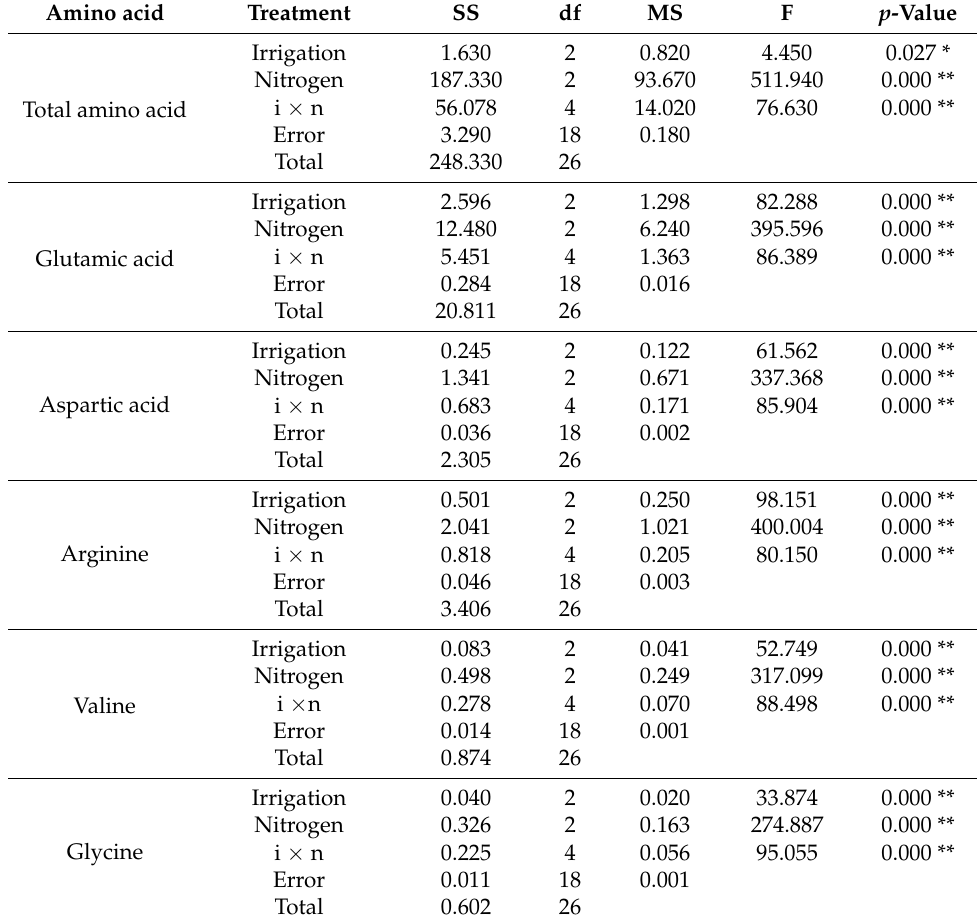
Table 5. Results of ANOVA on the effect of irrigation and nitrogen application on amino acid compo-